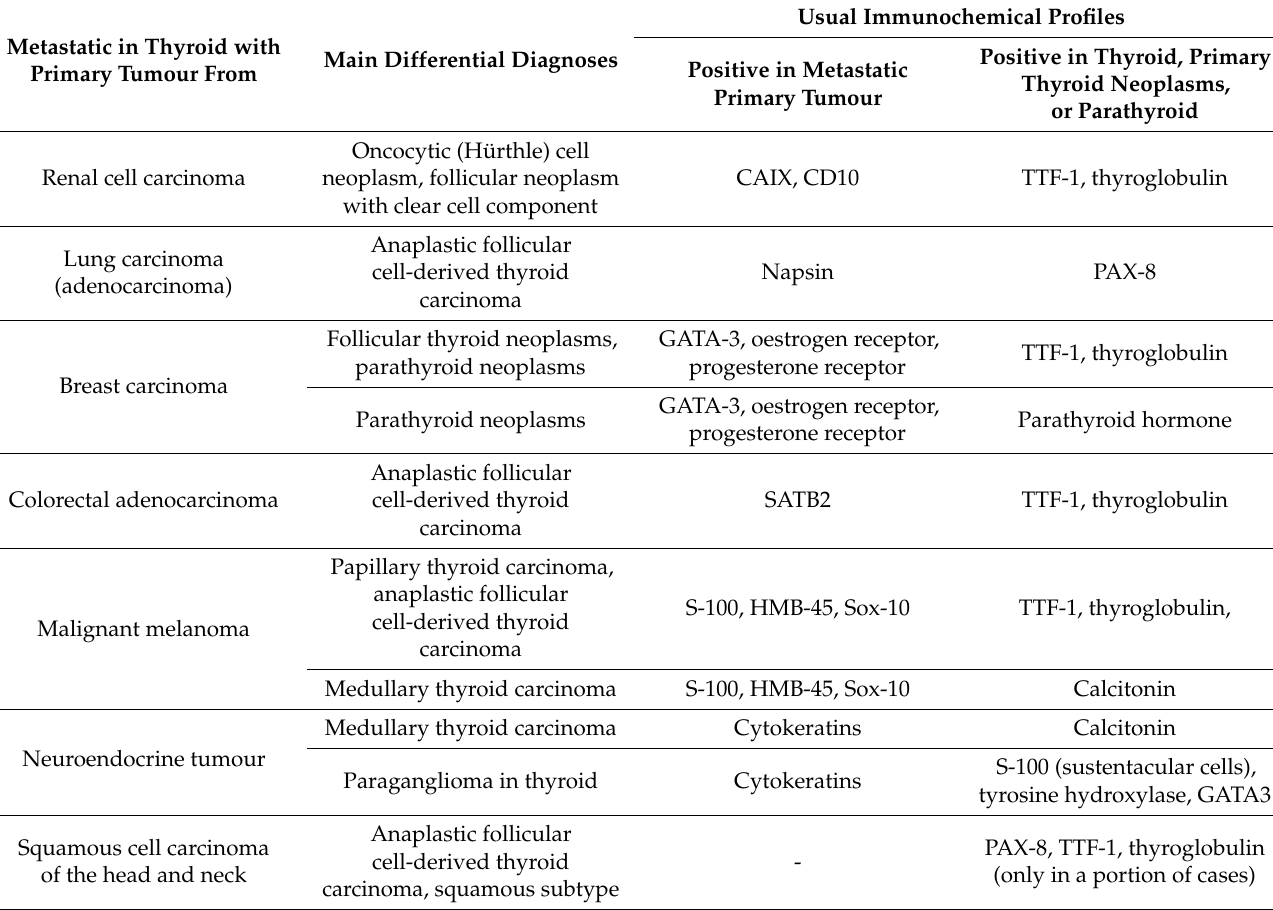
Table 4. Immunohistochemical profiles for common differential diagnoses of metastatic cancer in the thyroid versus primary thyroid